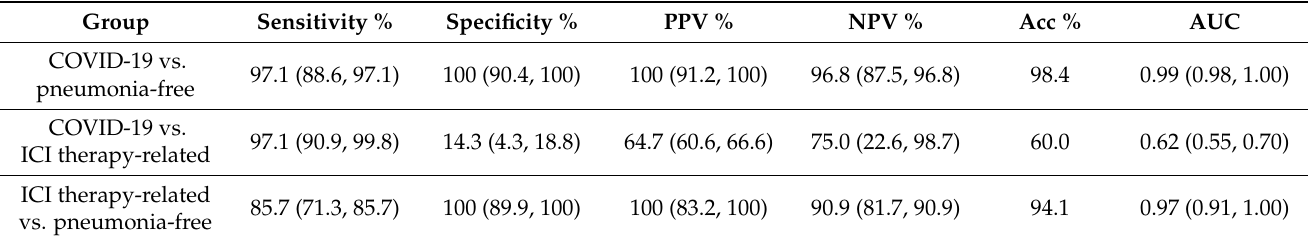
Table 2. Diagnostic performance of deep learning algorithm across the different group comparisons. Values in parentheses are 95% CI. PPV = positive predictive value, NPV = negative predictive value; Acc = accuracy; AUC = area under the receiving operating curve (ROC). COVID-19 = coronavirus disease 2019. ICI = immune checkpoint inhibitor. Group